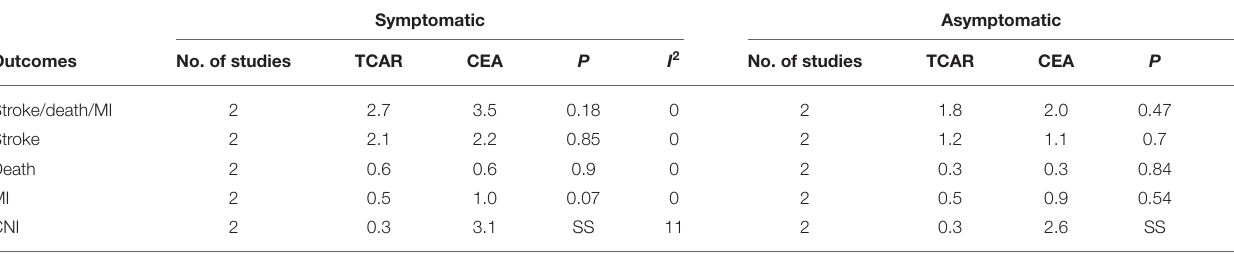
TABLE 4 | Subgroup analysis of symptomatic or asymptomatic status for carotid stenosis treated by TCAR or CEA.